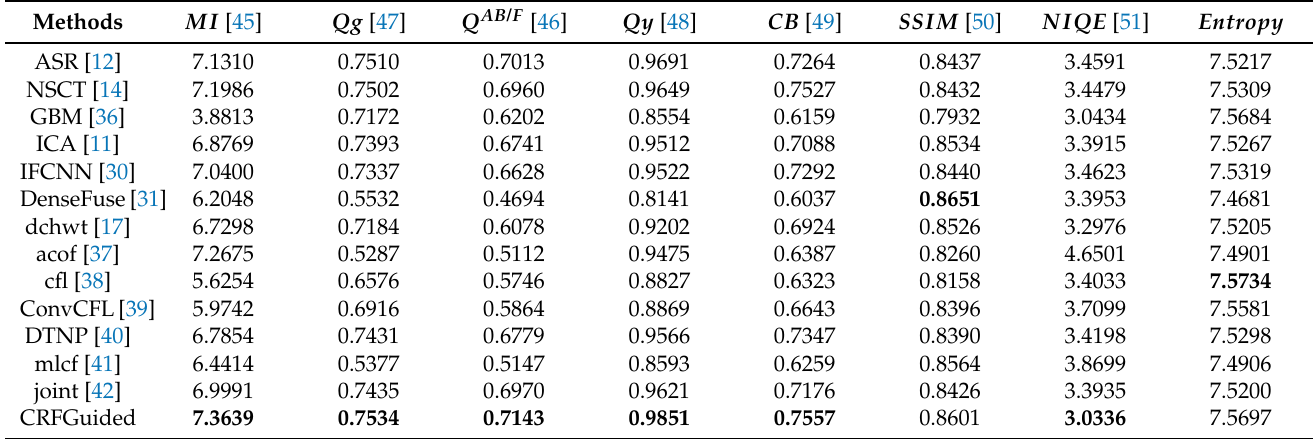
Table 1. Objective evaluation for the Lytro dataset [35]. Lower values for NIQE indicate better fused image quality, while for rest metrics higher values indicate better fused image quality.